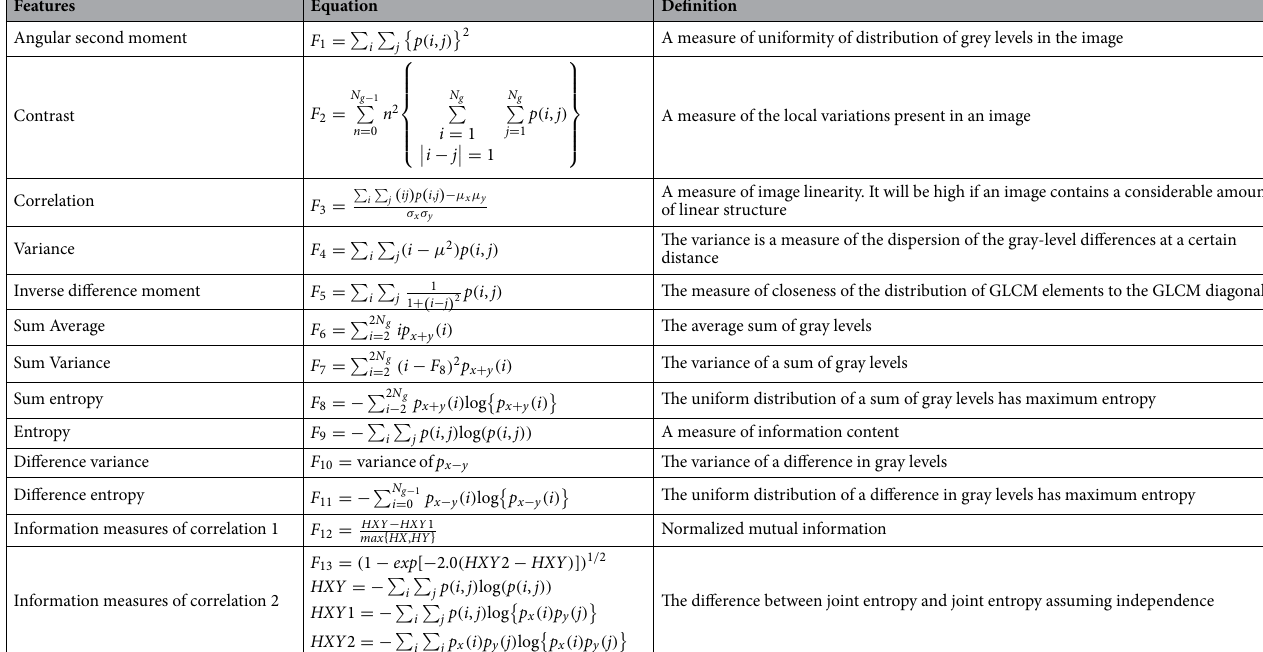
Table 3. Textural features used in the formation of